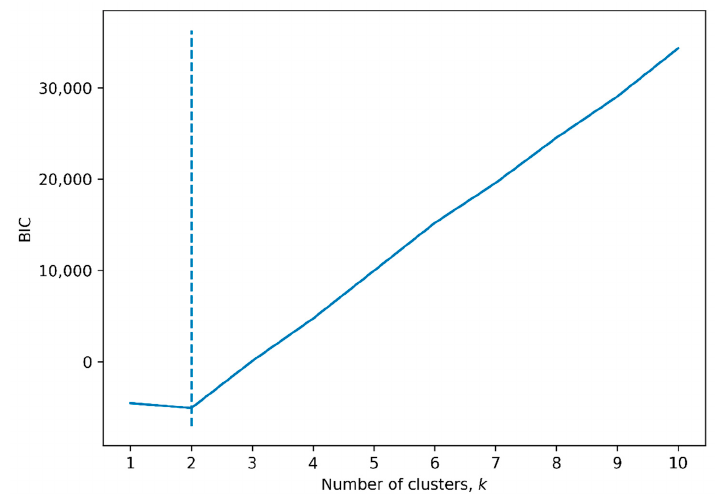
Figure 6. BIC for number of clusters in a GMM. Shown is the Bayesian information criterion (BIC) versus the number of clusters in a Gaussian mixture model (GMM). The dotted line indicates the minimum BIC at two clusters.